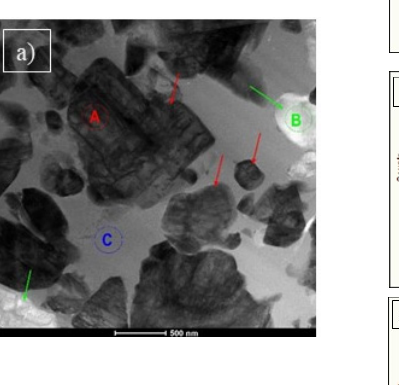
Figure 12. STEM micrograph in BF of sample C3 ( a ); the results of the chemical analysis performed for the area marked as A ( b ) and B ( c ) and C ( d ).